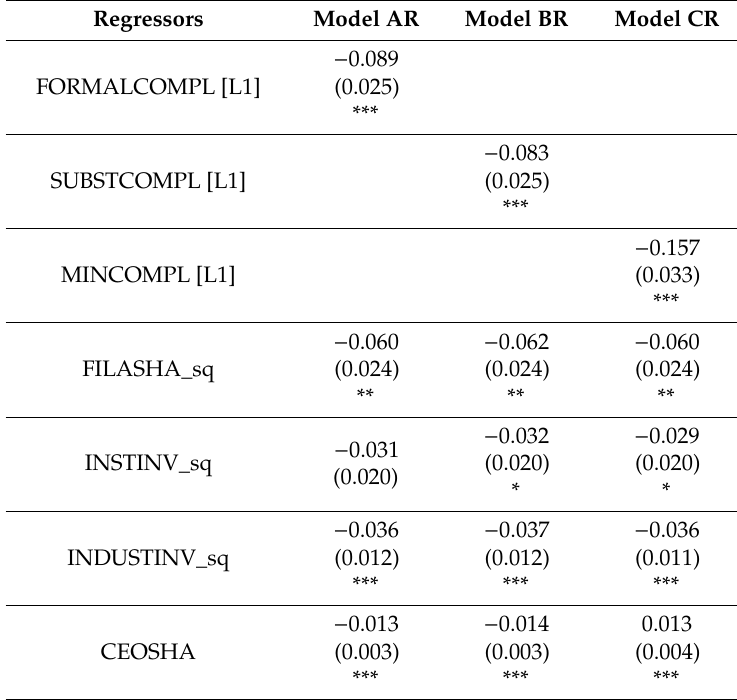
Table 11. Estimation results of robustness